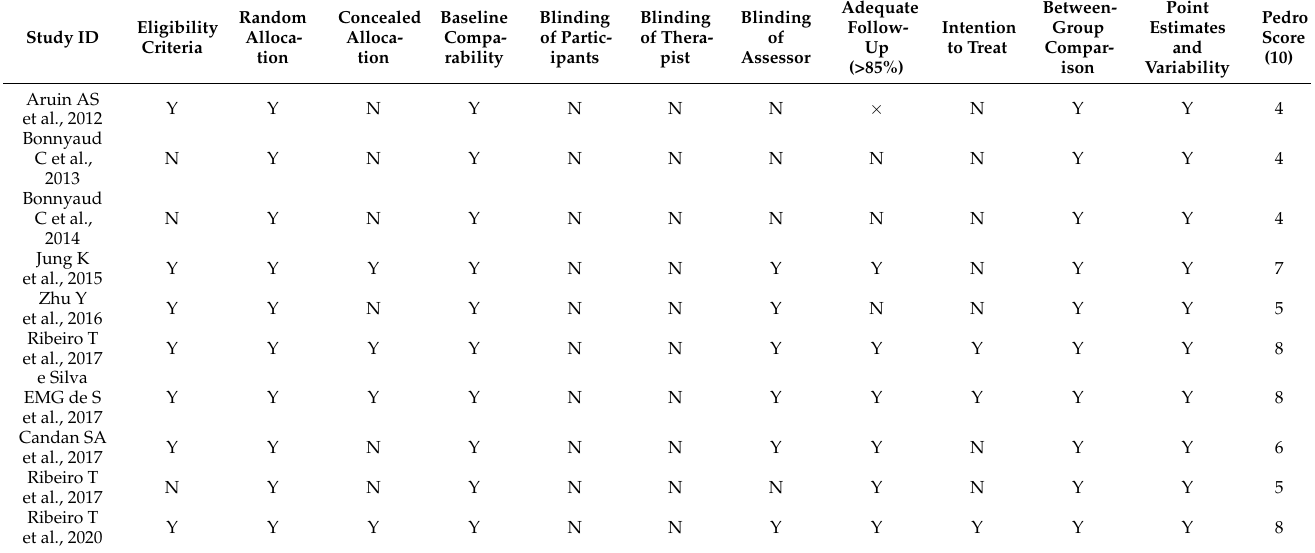
Table 3. Quality assessment for randomized control trials (RCTs) using Physiotherapy Evidence Database (PEDro) scale.